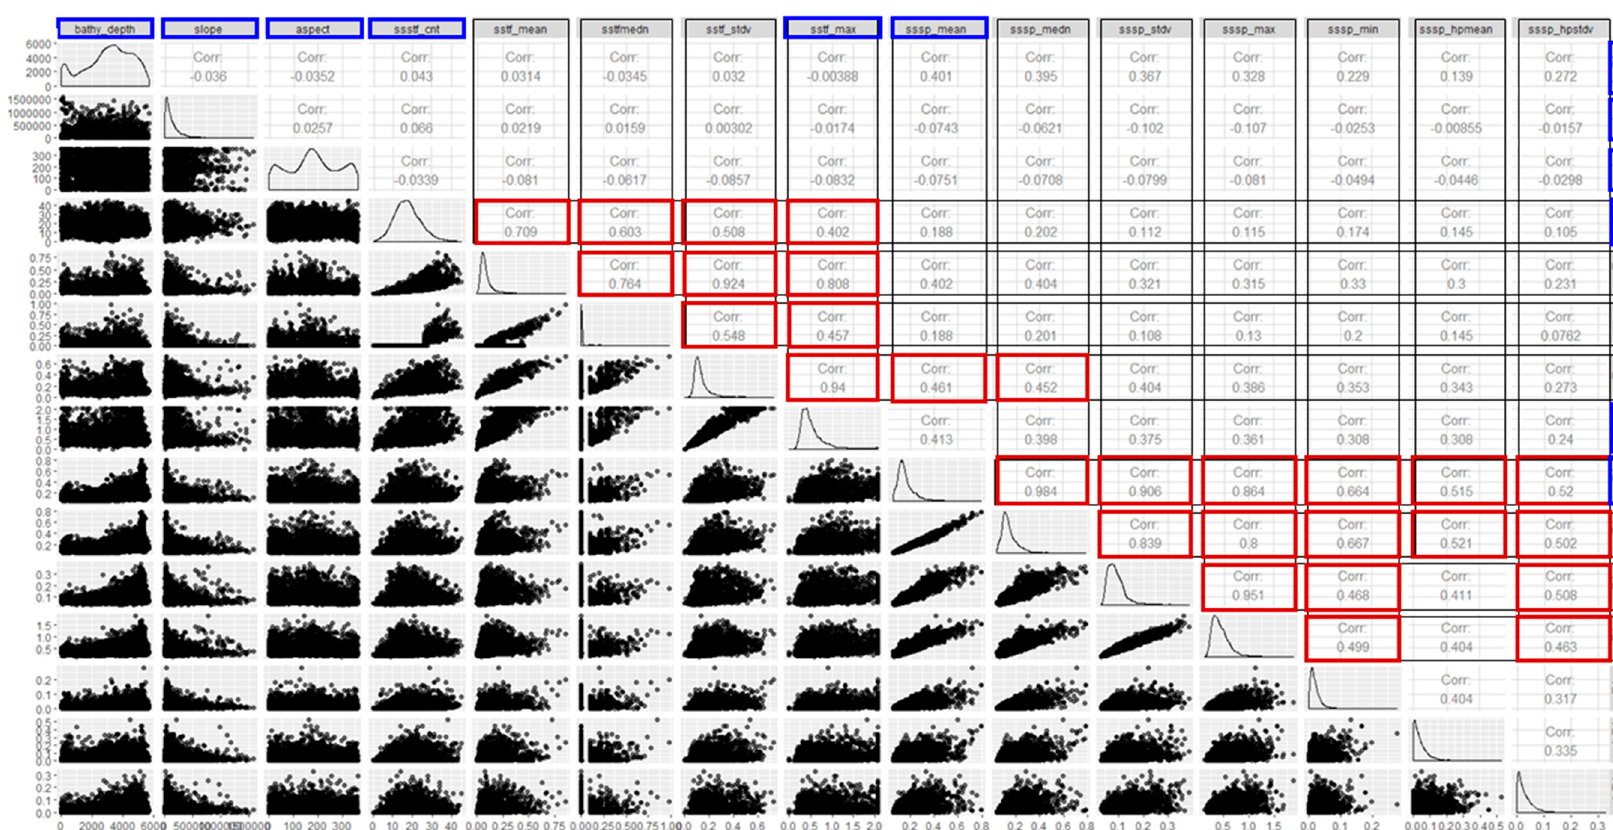
Figure A2. An example of the correlation analysis to identify and remove inter-correlated parameters. The NAA case study areas correlation matrix is shown. Red boxes are overlaid to highlight any correlation value over the threshold (0.45). Blue boxes highlight those parameters that were selected as inputs to the dredging stage of GLM development.